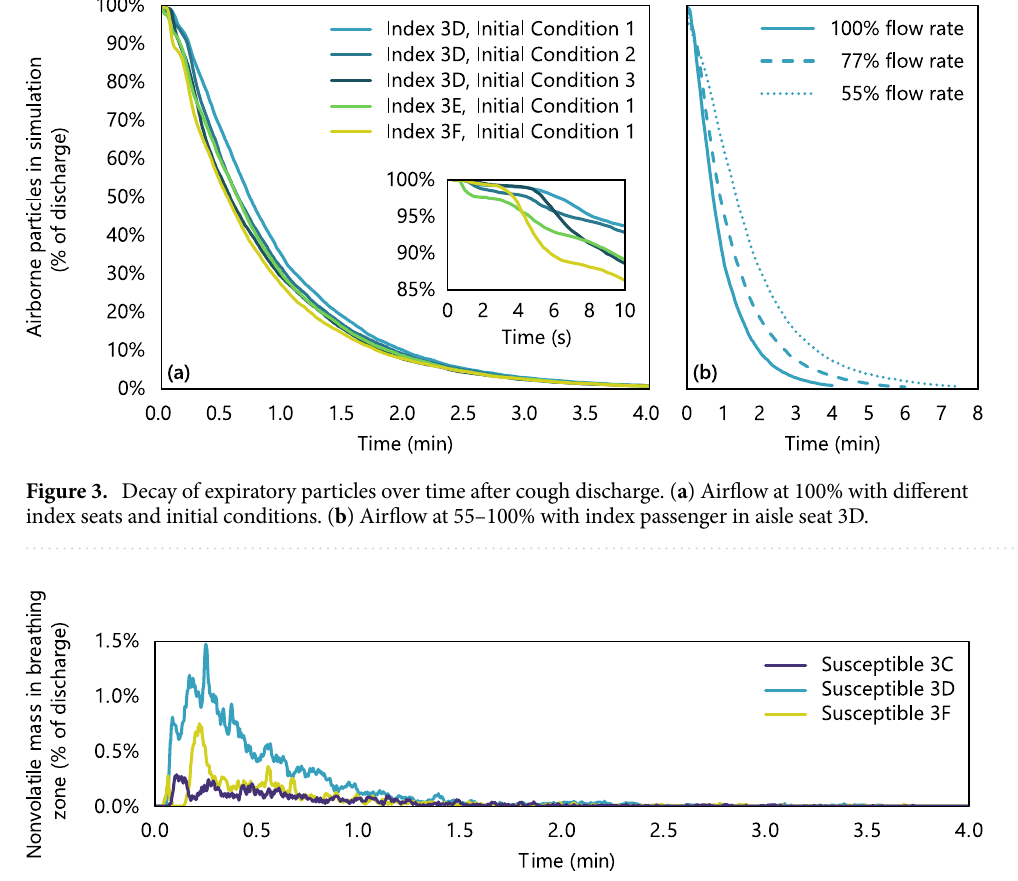
Figure 4. Amount of expiratory material present in the breathing zones of susceptible passengers over time after cough discharge from an index passenger in middle seat